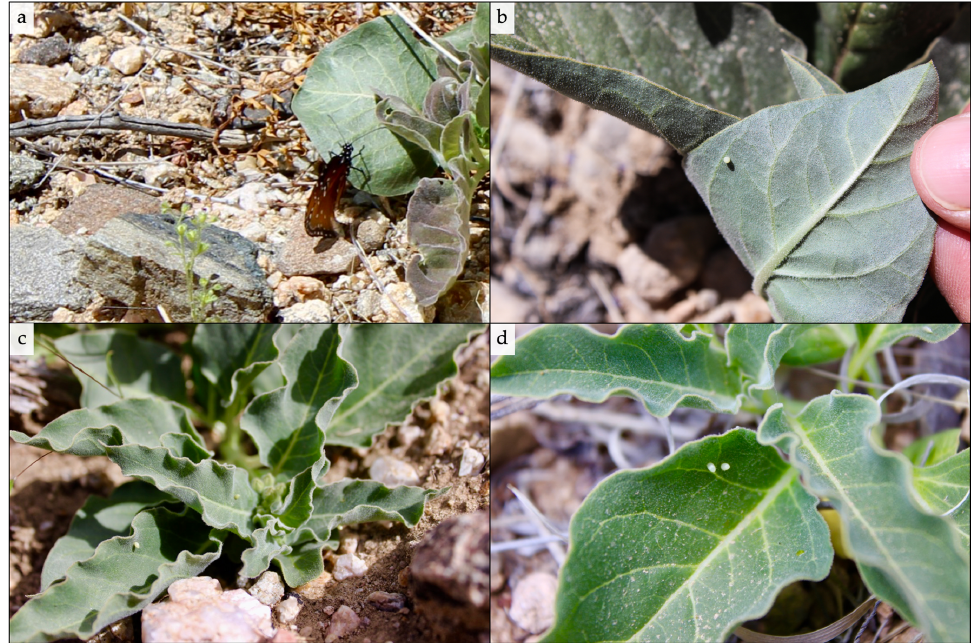
Figure 6. Queen butterfly oviposition on Mojave milkweed host plants during the breeding season, 27 April–1 June 2017, Ivanpah Valley, Mojave Desert, California, USA. ( a ) Adult queen butterfly, with abdomen under a leaf, ovipositing on a low-lying, young Mojave milkweed; ( b ) Commonly encountered egg placement on abaxial (underside) surface of Mojave milkweed leaf; ( c ) Three eggs on three leaves of an adult Mojave milkweed, note unopened flower buds behind front leaves of plant; ( d ) Two individual eggs laid adjacent to one another on the adaxial (upper side) surface of a Mojave milkweed leaf. Photographs by Steve Grodsky.